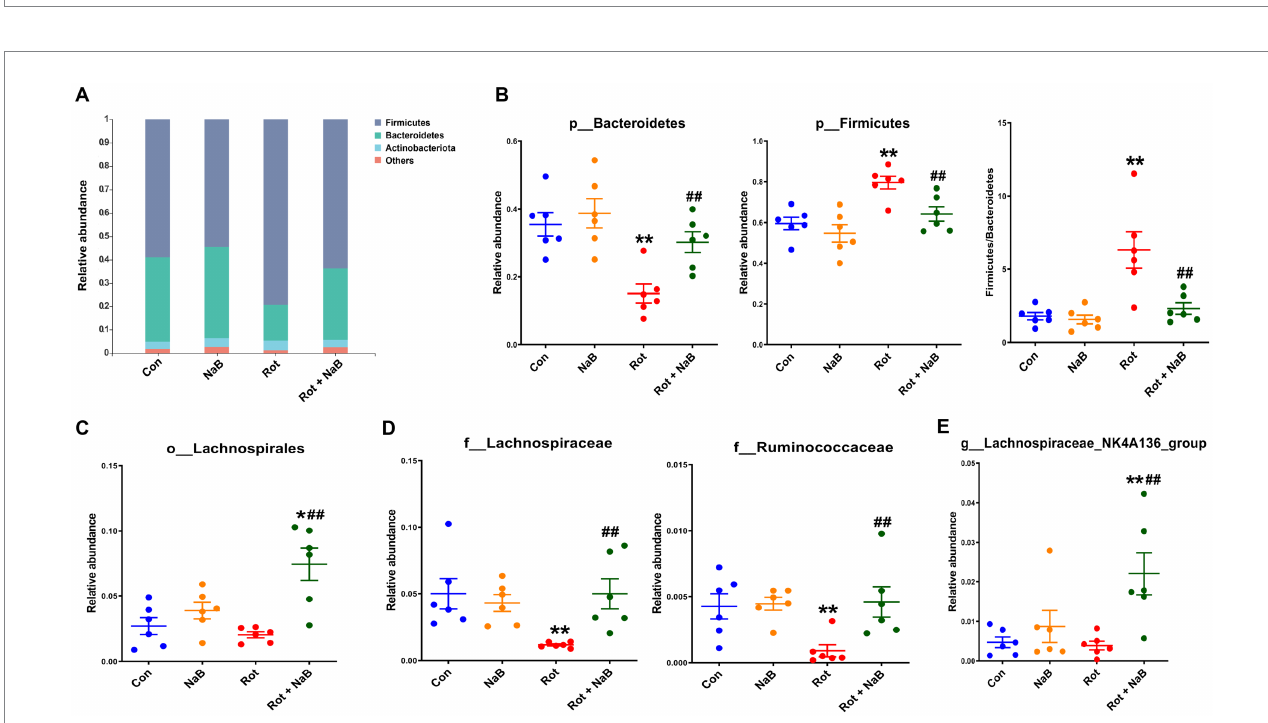
FIGURE 5 NaB reverses rotenone-induced alteration of gut microbial composition. (A) Bar plots of relative abundance of different groups at phylum level. Bacterial taxa with different abundance between groups at (B) phylum, (C) order, (D) family, and (E) genus level. n = 6 per group. The data represent the mean ± SEM. * p < 0.05, ** p < 0.01 vs. Con group; ## p < 0.01 vs. Rot group. Con: control; NaB: sodium butyrate; Rot: